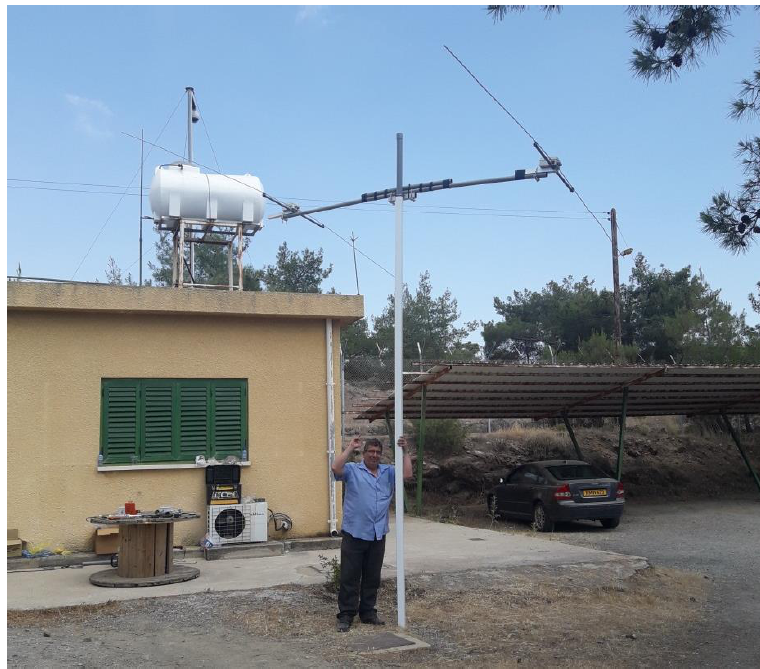
Figure 13. The two-dipole phased array in its final form.